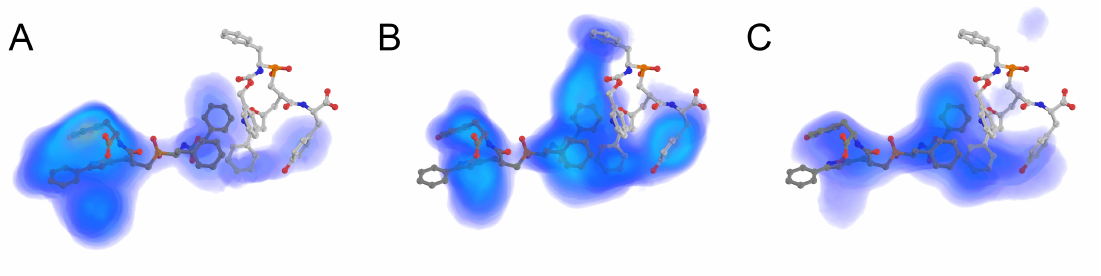
Figure 2. Occurence maps for the C.ar atom type (e.g., aromatic carbon) inside angiotensin-converting enzyme binding site for ( A ) AutoDock Vina, ( B ) PLANTS and ( C ) LeDock. Density increases from blue through yellow to purple. Phosphonic tripeptide from 2XY9 is shown in sticks model. Table 1. Unique peptides with experimental IC 50 values from top 10 predictions